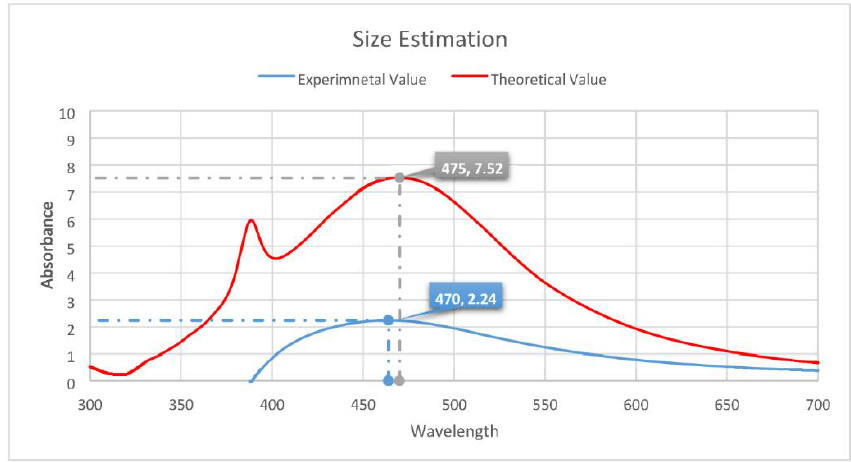
Figure 6. Estimating the size of the AgNPs. For the experimental value, the absorbance was revealed to be 2.24 at a wavelength of 470. This is compared with the theoretical value, with an absorbance of 7.52 and a wavelength of 475, to estimate the size of the AgNPs formed.